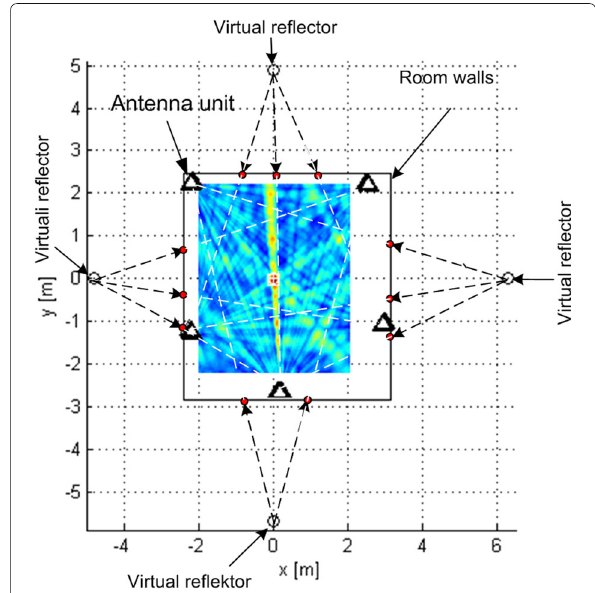
Fig. 11 Criterion function for stage 2, G 1 , Rice factor 10 dB, and N = 1024 with